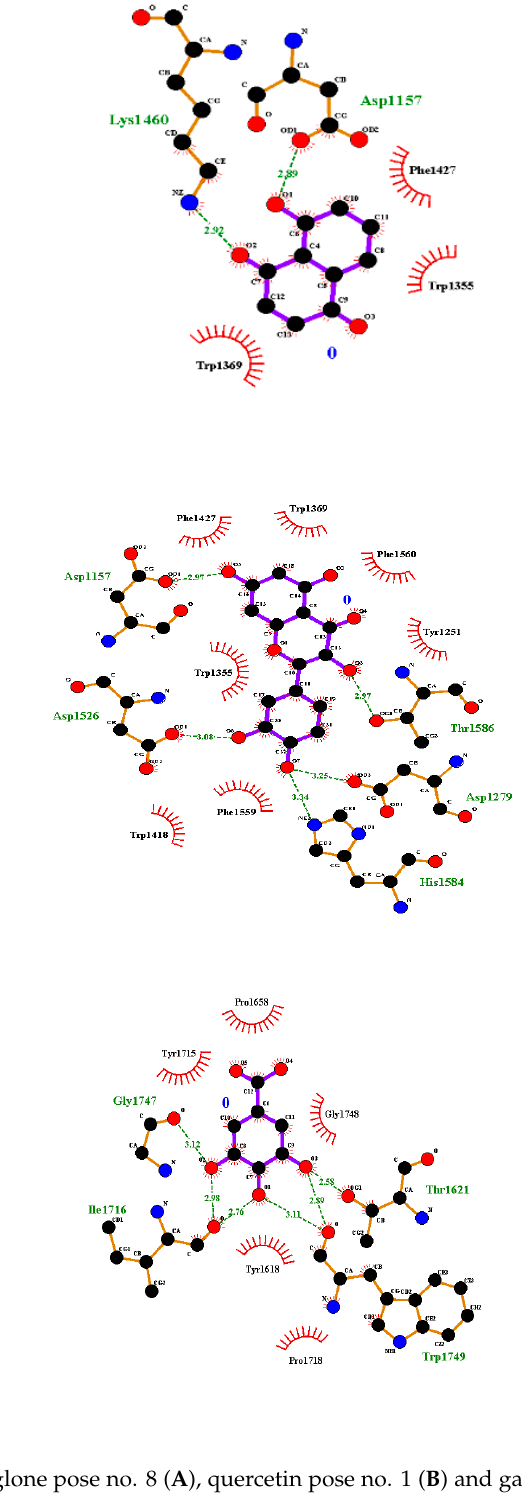
Figure 2. 3D H-bonding Interactions of juglone pose no. 8 ( A ), quercetin pose no. 1 ( B ) and gallic acid pose no. 3 ( C ) with binding sites of transcriptional regulator 1IK3.